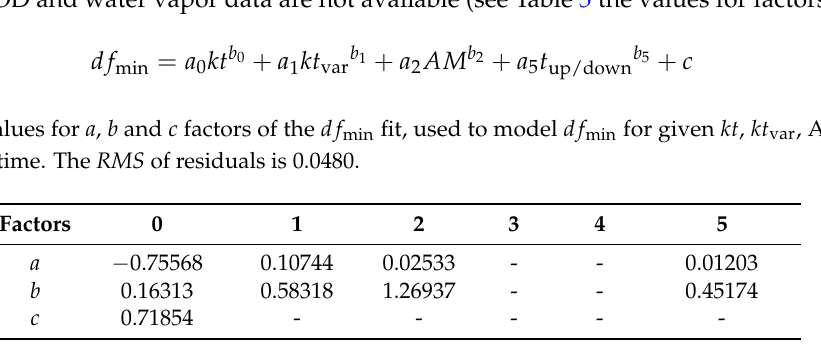
Case 4 : AOD, water vapor and up/down time data are not available (see Table 6 the values for factors a , b and c